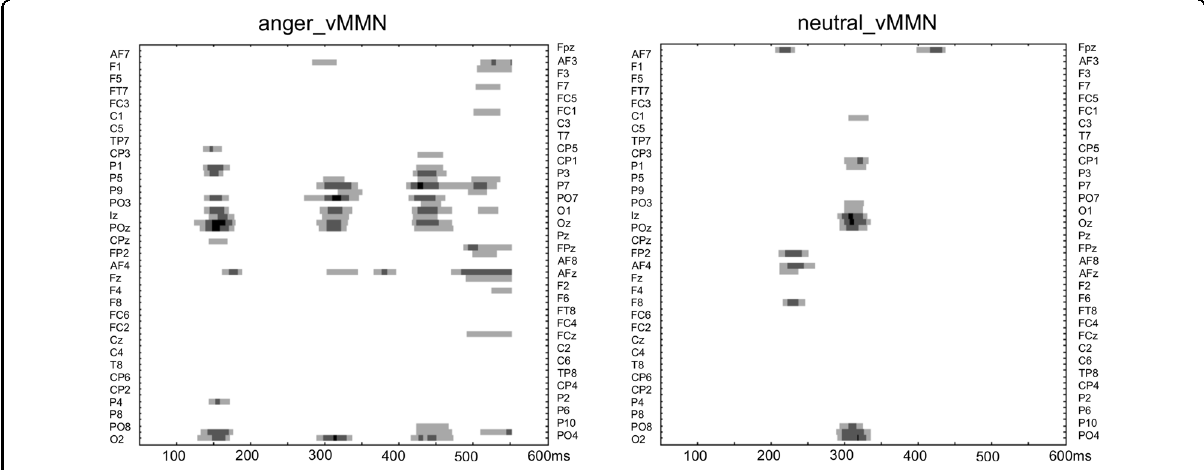
Fig. 3 Permutation tests analyses. Permutation tests analyses showing statistical signi fi cance between groups over the entire scalp (64 electrodes) in the 50 – 600 ms latency range for the anger vMMN (left) and the neutralv MMN (right). Statistical signi fi cance is represented by light gray, gray, and black colors ( P < 0.05, P < 0.01, and P < 0.001,